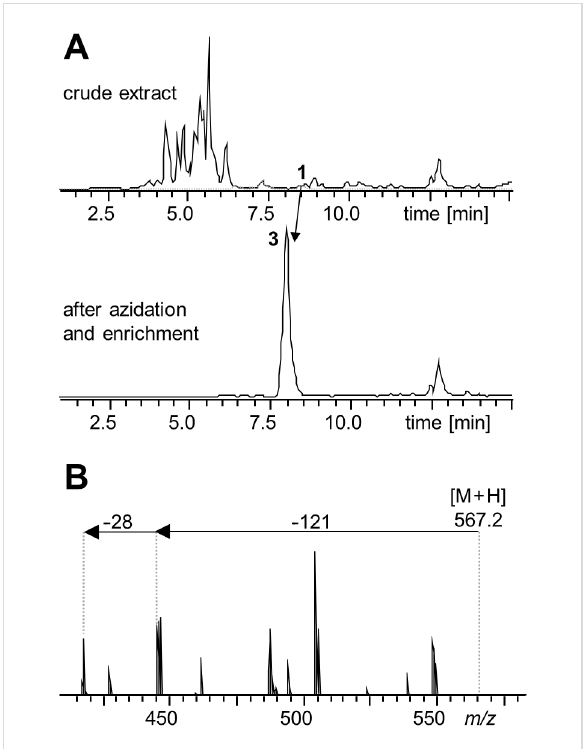
Figure 1: (A) HPLC–MS base peak chromatograms of a crude XAD extract of P. luminescens TT01 and after azidation and azide enrich- ment. The t R of 1 is indicated in the crude extract. After enrichment, one distinct peak at 8.1 min corresponding to 3 is visible. (B) The char- acteristic MS 2 fragmentation pattern of the derivatized azide 3 is shown highlighting the neutral loss of carbamate ( − 121) and dini- trogen ( − 28) as characteristic fragments for CARR